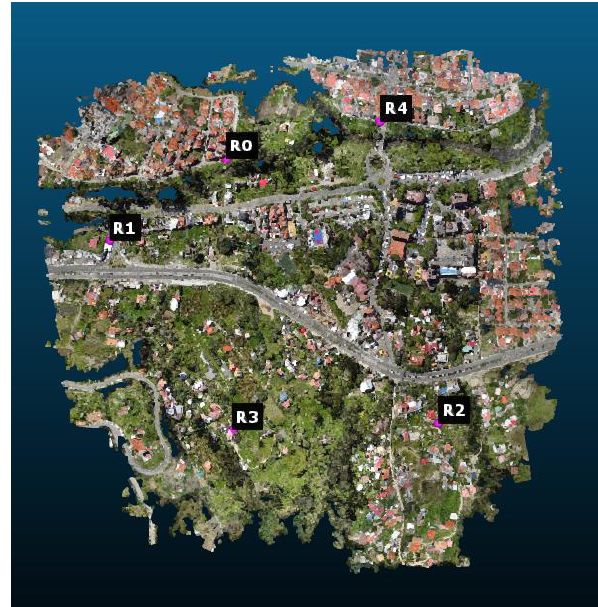
Figure 9. Reference points locations UAV – UAV.